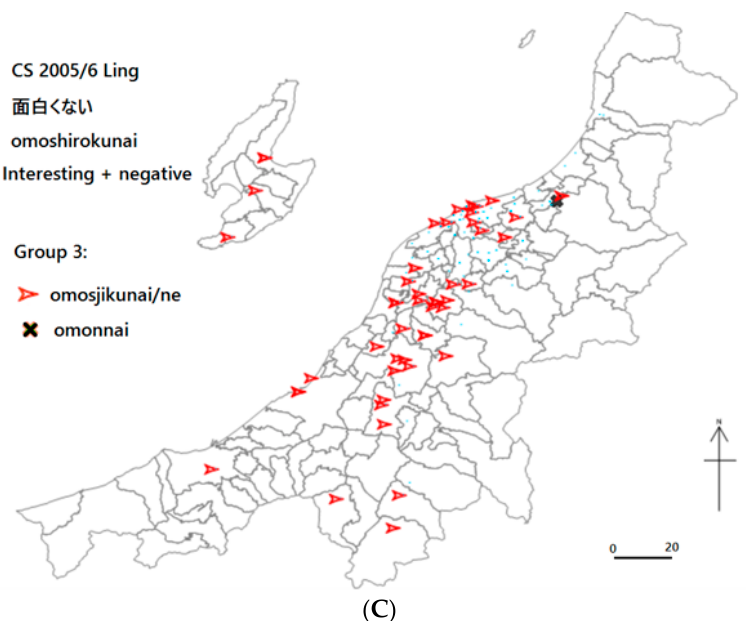
Figure 14. ( A ) Map (Group 1) of omoshirokunai “interesting” + negative in Niigata: 2005/6 CS Survey. ( B ) Map (Group 2) of omoshirokunai “interesting” + negative in Niigata: 2005/6 CS Survey. ( C ) Map (Group 3) of omoshirokunai “interesting” + negative in Niigata: 2005/6 CS Survey.